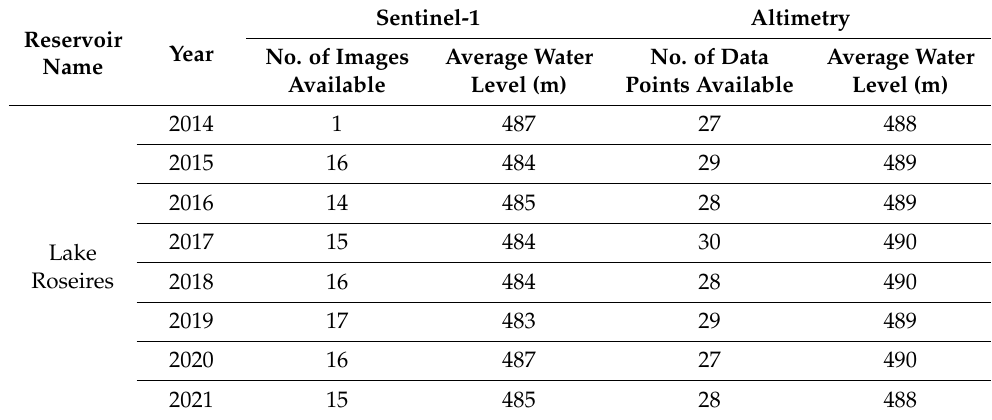
Table 1. Average water levels derived from the two sources for Lake Roseires.